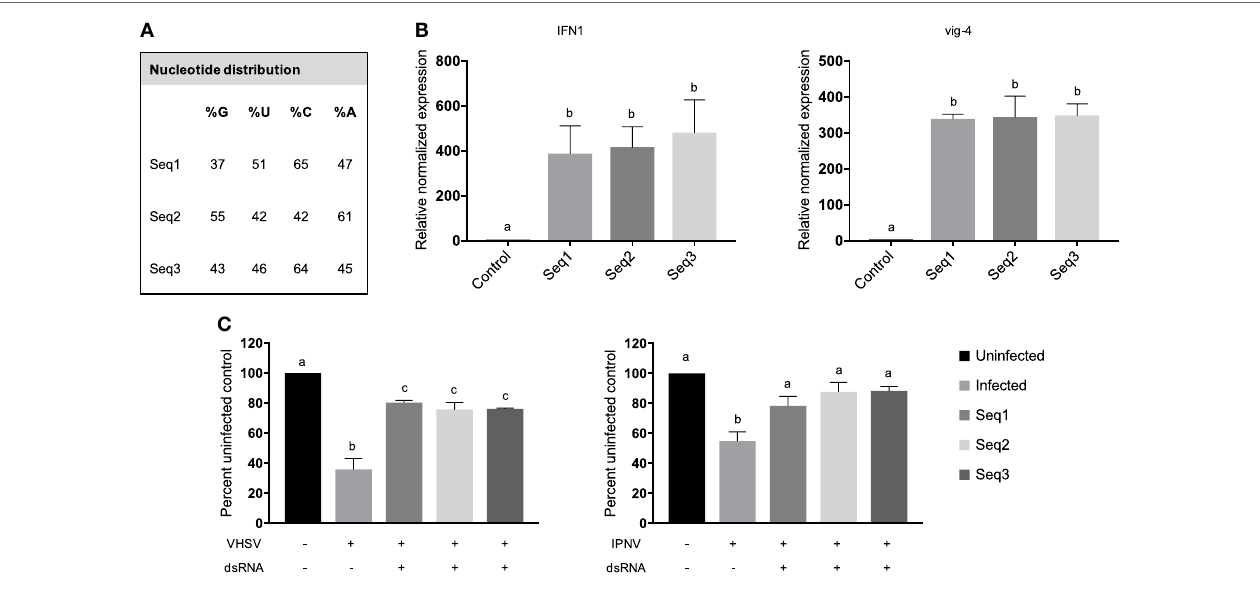
FigUre 5 | ivt - dsRNA of the same length and different sequence induced similar levels of IFN1 and vig-4 transcripts and protective antiviral states against viral hemorrhagic septicemia virus (VHSV) and infectious pancreatic necrosis virus (IPNV) in RTG-2 cells. Three in vitro transcribed dsRNA molecules of the same length, but different source sequences were used to test the effects of sequence on innate immune response. (a) Genomatix was used to calculate the nucleotide distribution within the three sequences, and the percentage of each nucleotide is shown. (b) RTG-2 cells were treated with 0.05 nM dsRNA for 6 h, and IFN1 and vig-4 transcripts were measured by qRT-PCR, normalized to β -actin, and presented as values relative to an unstimulated control. (c) RTG-2 cells were pretreated with 0.05 nM dsRNA for 3 h and then infected with VHSV at a multiplicity of infection (MOI) of 10 or IPNV at an MOI of 0.2. After 4–7 days, a fluorescent indicator dye, alamarBlue, was used to measure cell viability, and data are presented as the percentage of an untreated, uninfected control. Data represent three independent replicates and were analyzed statistically by one-way ANOVA, alpha = 0.05; a P value < 0.05 considered